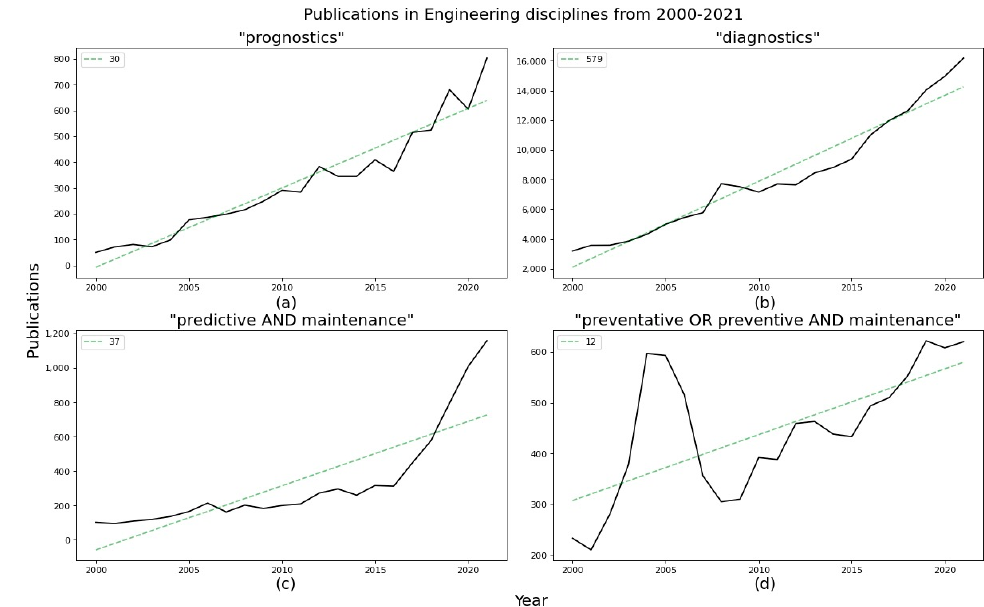
Figure 1. Publications in engineering disciplines from 2000–2021 that include terms: ( a ) “Prognos- tics”; ( b ) “Diagnostics”; ( c ) “Predictive Maintenance”; ( d ) “Preventative OR Preventive AND Maintenance”. Includes slope (dashed line), a measure of the rate of increase in publications over time (source: Scopus).